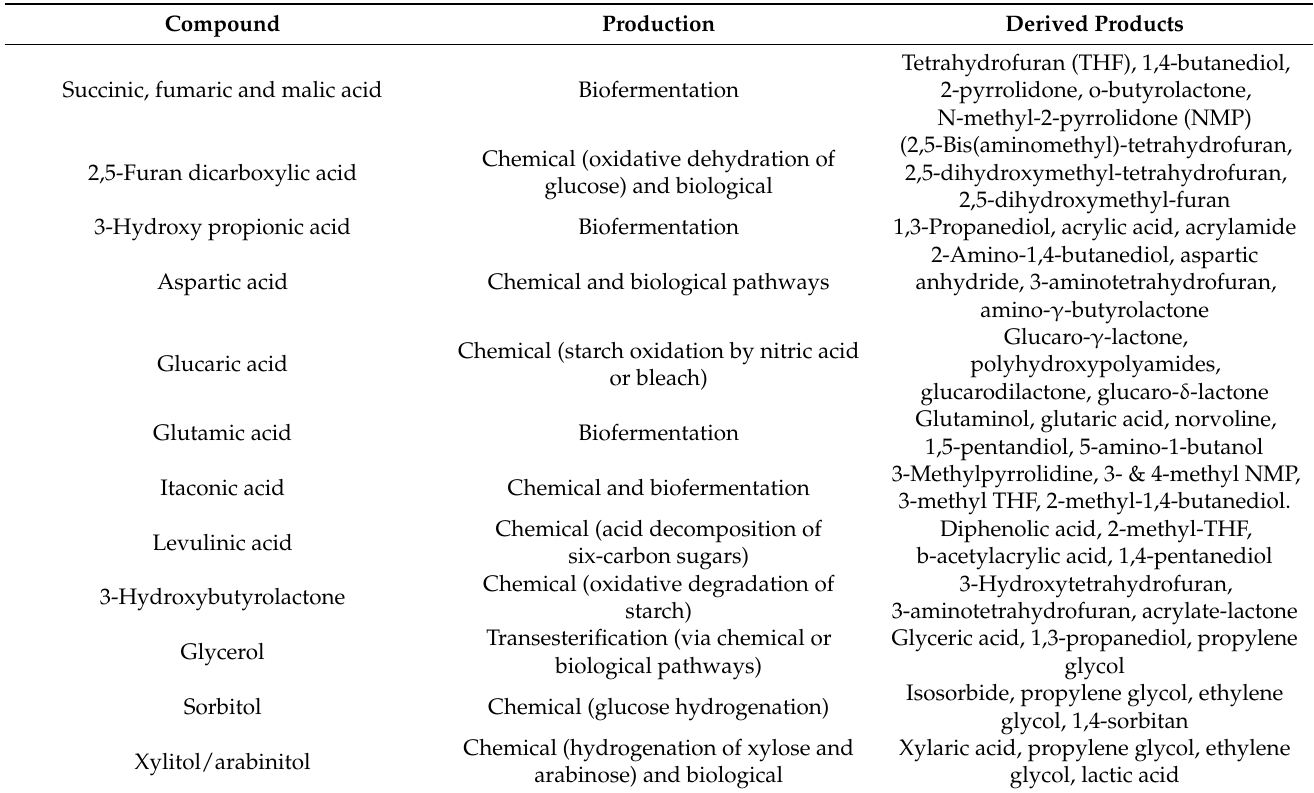
Table 7. Main building blocks and their derivatives obtained from cellulose and hemicellulose